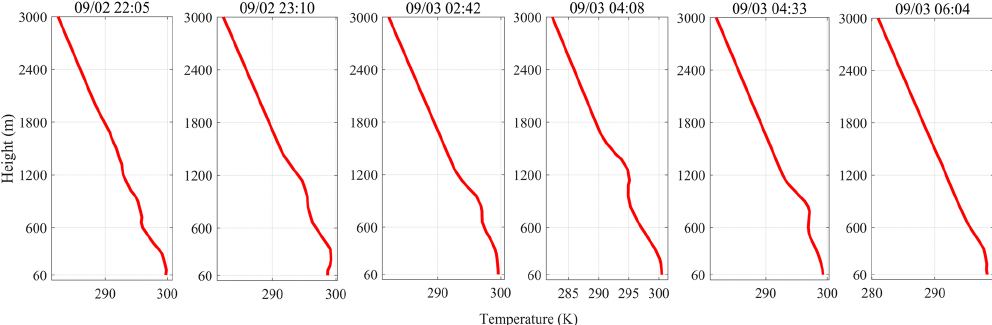
Figure 8. Temperature profiles from the evening of 2 September 2020 to the early hours of 3 September 2020.